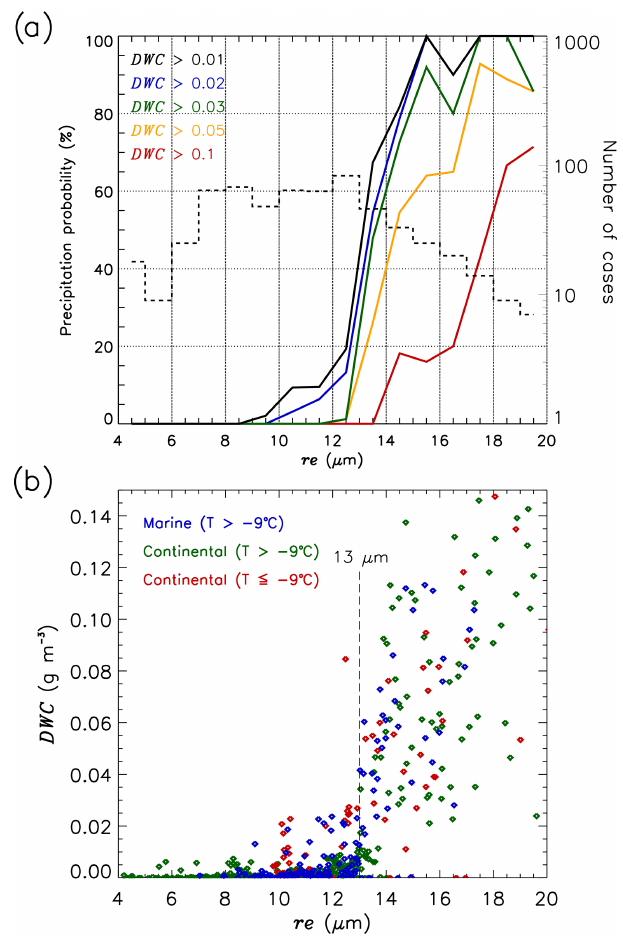
Figure 3. (a) Precipitation probability as a function of r e for dif- ferent drizzle water content (DWC) thresholds (black: DWC > 0 . 01gm − 3 ; blue: DWC > 0 . 02gm − 3 ; green: DWC > 0 . 03gm − 3 ; yellow: DWC > 0 . 05gm − 3 ; red: DWC > 0 . 1gm − 3 ) measured within convective cloud tops over the Amazon Basin and Atlantic Ocean. The dashed line indicates the number of cases for each r e size interval (right axis); each case represents a 1s in-cloud mea- surement. (b) Effective radius ( r e ) as a function of DWC measured within convective cloud tops over the Atlantic Ocean for tempera- tures ( T ) warmer than − 9 ◦ C (in blue), and over the continent for T > − 9 ◦ C (in green) and T ≤ − 9 ◦ C (in